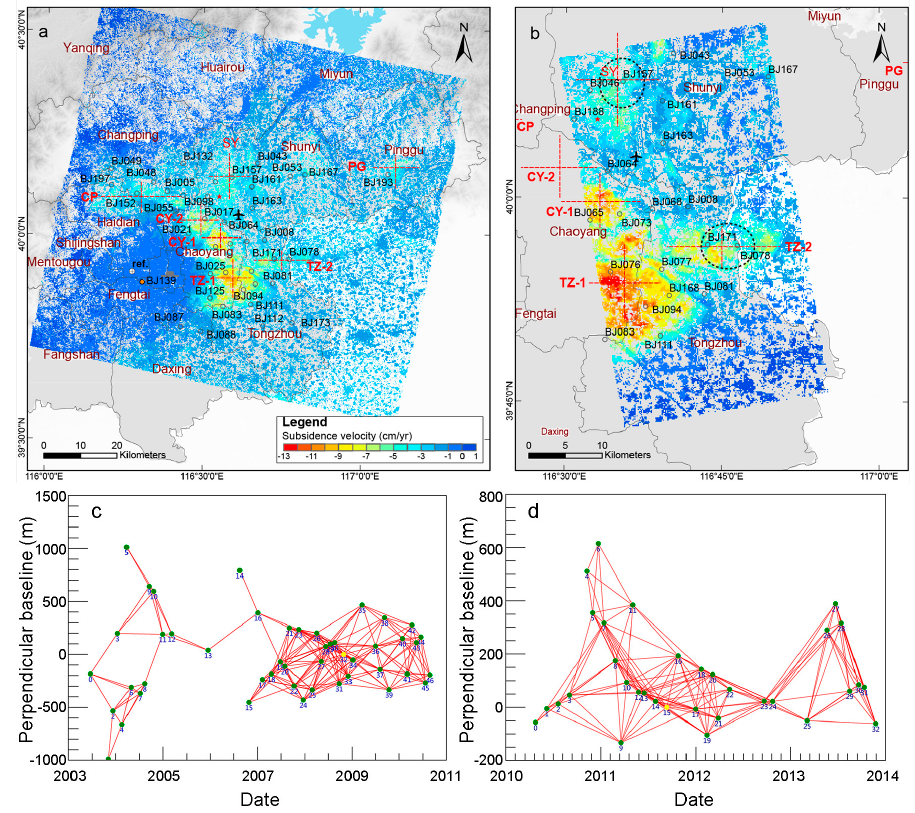
Figure 2. Line of sight velocity maps and connections from two satellite tracks: ( a ) Envisat ASAR descending track (June 2003–August 2010) with maximum subsidence of 10.06 cm/year and maximum uplift of 0.64 cm/year. ( b ) TSX/TDM ascending track (April 2010–November 2013) with maximum subsidence of 12.86 cm/year and maximum uplift of 0.92 cm/year. InSAR time series profiles for two periods are marked by red dashed line and are detailed in Figures 3 and 4, respectively. ( c ) Connection graph generation from Envisat ASAR interferogram pairs. ( d ) Connection graph generation from TSX/TDM interferogram pairs.